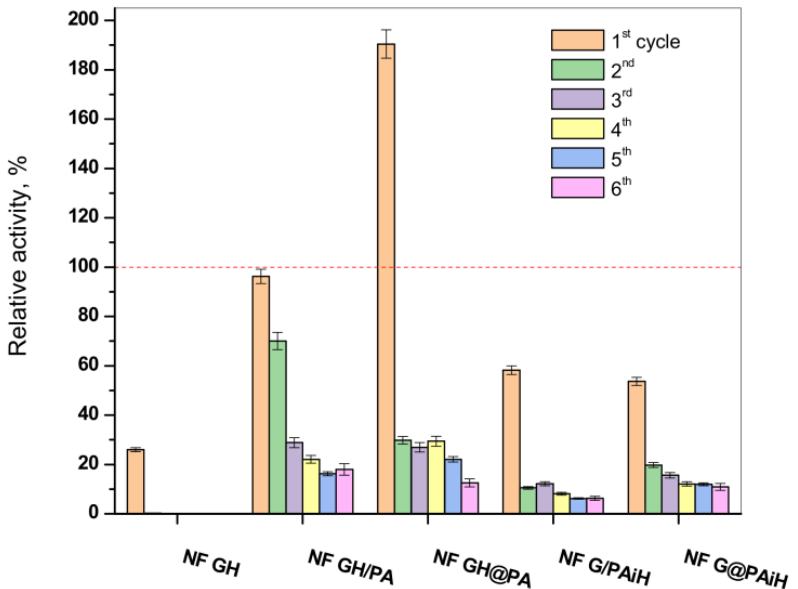
Figure 11. Relative activity of the PANF complexes measured after 1–6 cycles of utilization. The activity of the free GH dyad during its only cycle of use at 20 – 23 °C is taken as 100% (the dashed line). The NF GH system (mixed GOx/HPR NF without PA6 MP) survives only one cycle of use as well. In agreement with previous studies, the classical NF system comprising GOx and HRP disintegrates after the first cycle, making impossible its recuperation for more uses, which is also the case with the free enzyme dyad. In its first reaction cycle, the conventional bienzyme NF complex shows only up to 27% of the activity of the free enzymes. The latter is indicated with the dashed line in Figure